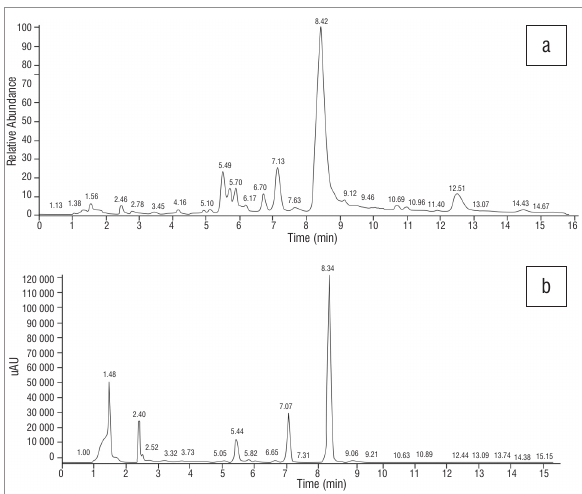
Figure 8: Chromatograms of Sceletium expansum derived from (a) electrospray ionisation mass spectroscopy and (b) high- performance liquid chromatography with